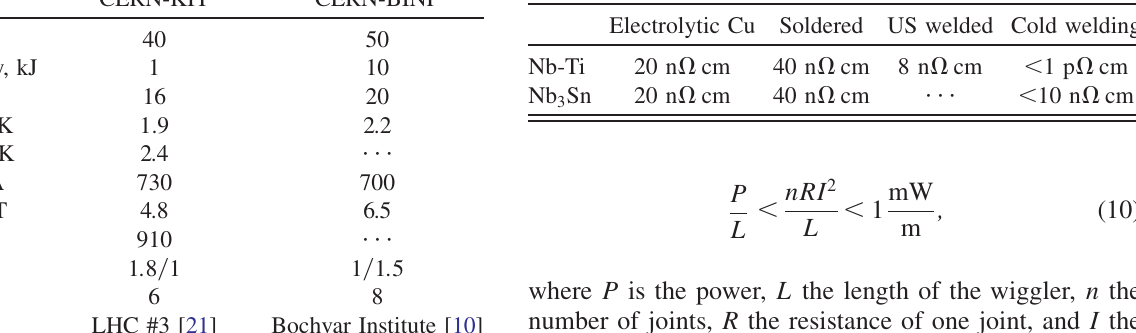
TABLE III. Parameters of short models. TABLE IV. Comparison of different joint technologies